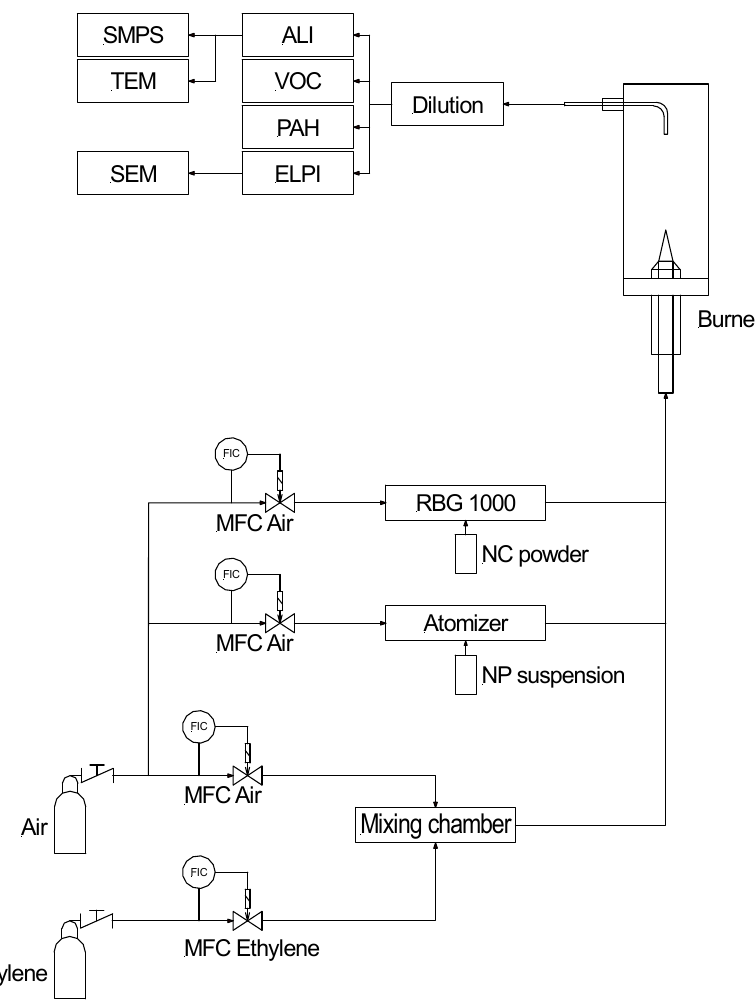
Figure 1. Setup for the thermal degradation of nanocomposite powders and nanoparticle suspensions with subsequent physicochemical and toxicological characterization.